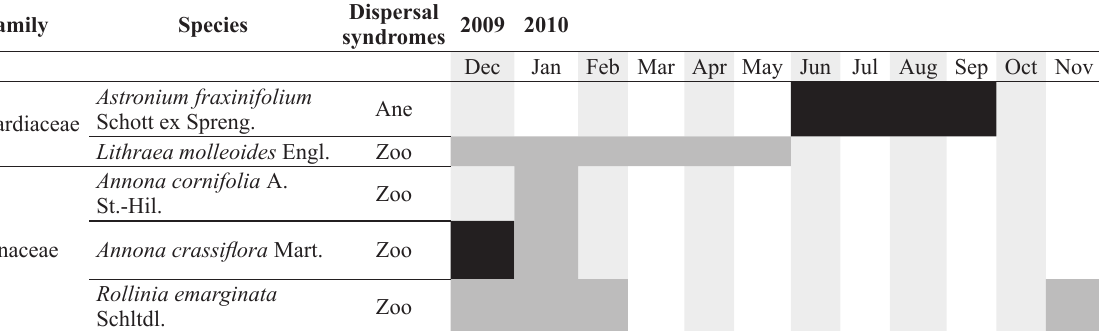
List of families and species, dispersal syndromes, flowering and fructification in the plots of an escarpment slope of the Serra de Maracaju, Mato Grosso do Sul, Brazil. (Jan = January, Feb = February, Mar = March, Apr = April, May = May, Jun = June, Jul = July, Aug = August, Sep = September, Oct = October, Nov = November, Dec = December; Ane = Anemochory, Zoo = Zoochory, Aut = Autochory; Flowering; Fructification; Flowering and Fructification. 2009 and 2010 represent the reproductive